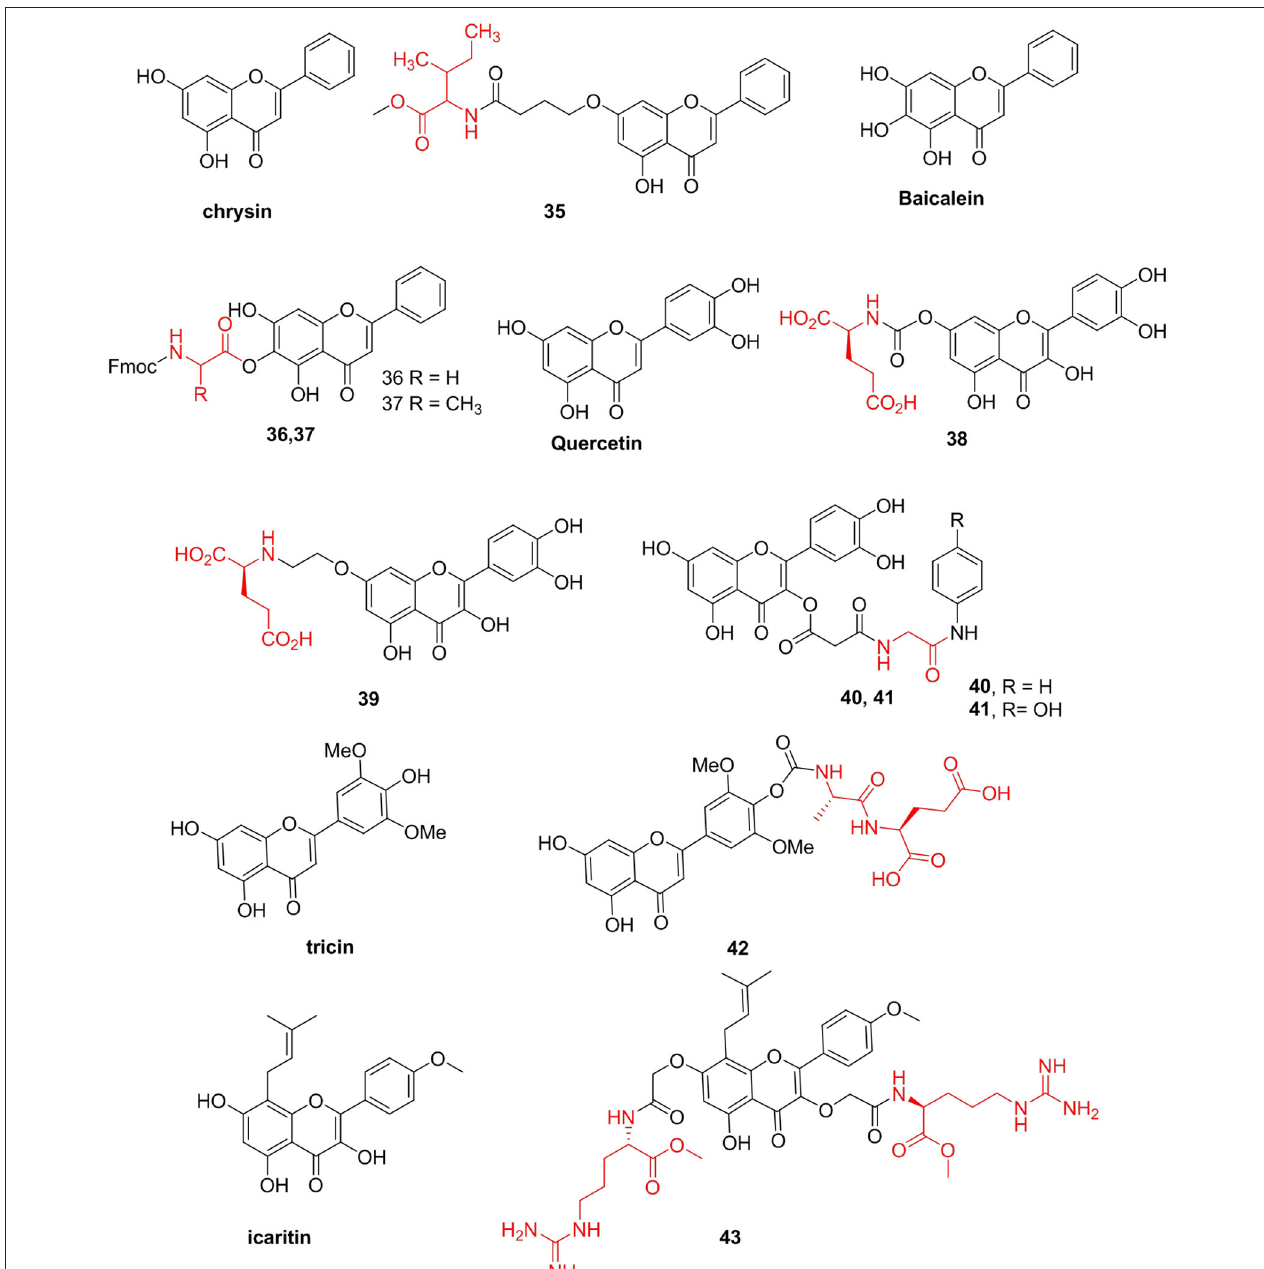
FIGURE 5 | Flavonoids amino acid